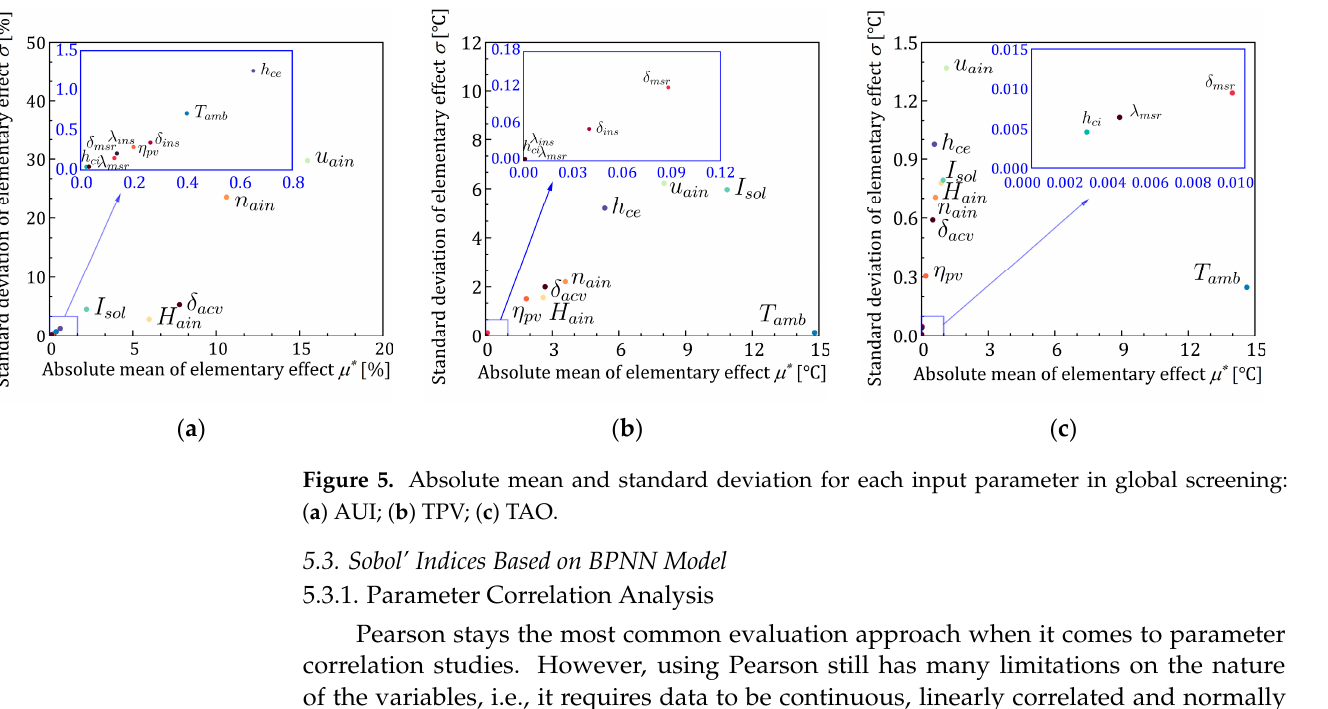
Figure 4. Probability distribution of three quantities of interest induced by 5200 sets of uncertain inputs: ( a ) Density and cumulative probability; ( b ) Probability plot; ( c ) Cumulative hazard.